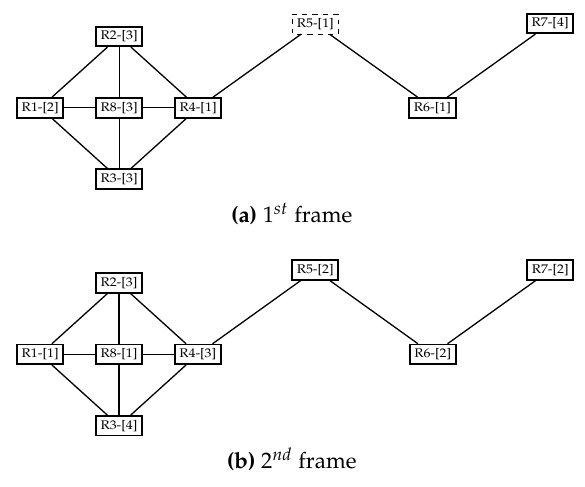
Figure 7. CORA scenario